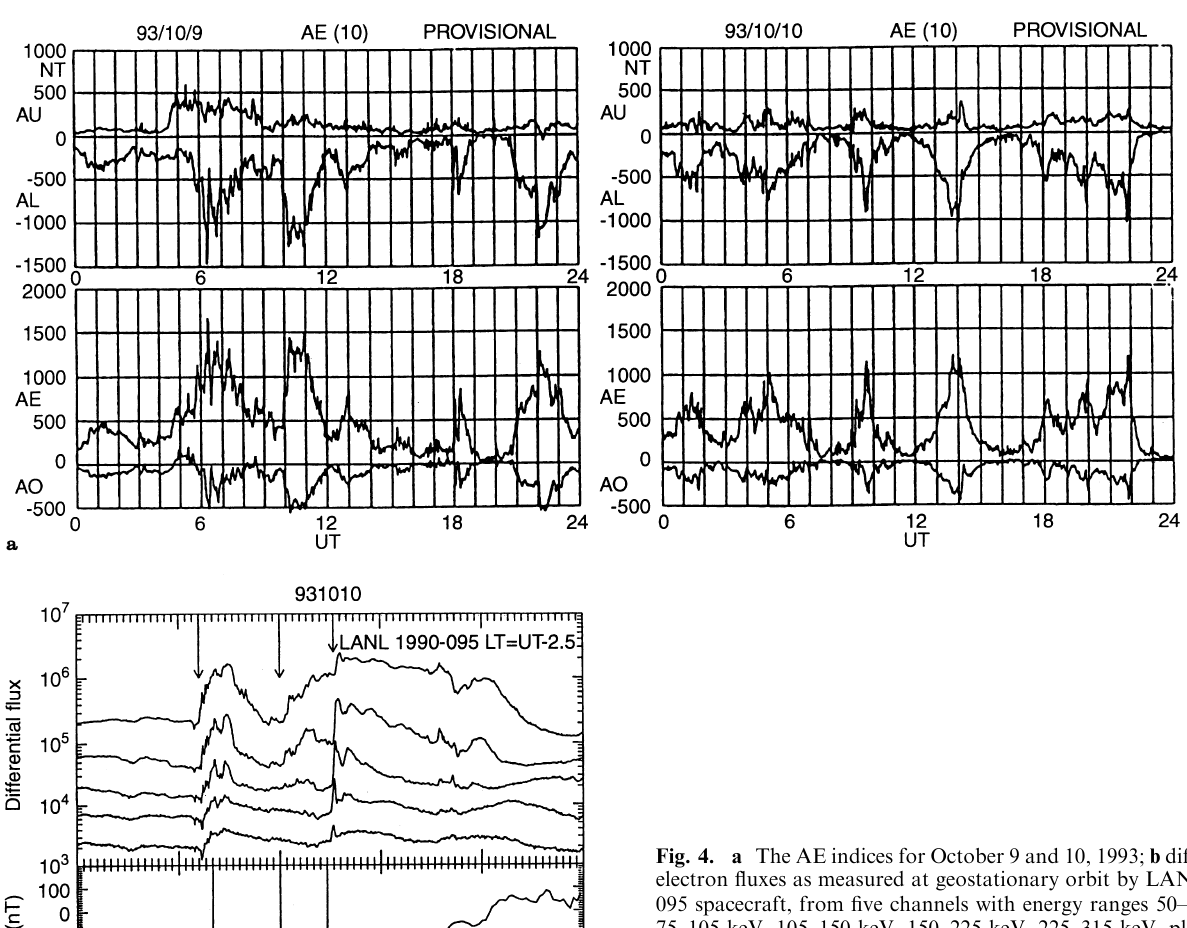
Fig. 4. a The AE indices for October 9 and 10, 1993; b di(cid:128)erential electron fluxes as measured at geostationary orbit by LANL 1990- 095 spacecraft, from five channels with energy ranges 50–75 keV, 75–105 keV, 105–150 keV, 150–225 keV, 225–315 keV, plotted respectively from the top to the bottom of the upper panel, for October 10, 1993 between 0000 UT and 0230 UT. The ground magnetic field measurements from Kiruna Observatory are also presented in the lower panel , for the